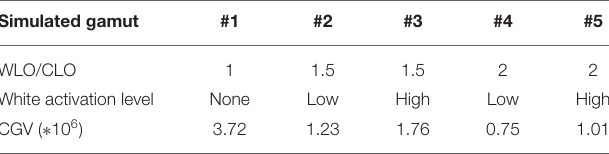
TABLE 1 | Gamut parameter settings and the corresponding CIELAB gamut